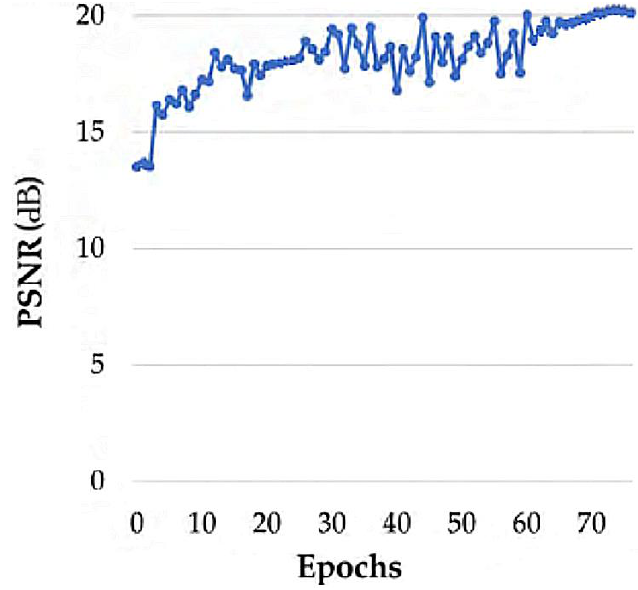
Figure 7. Training PSNR of SlimDeblurGAN.